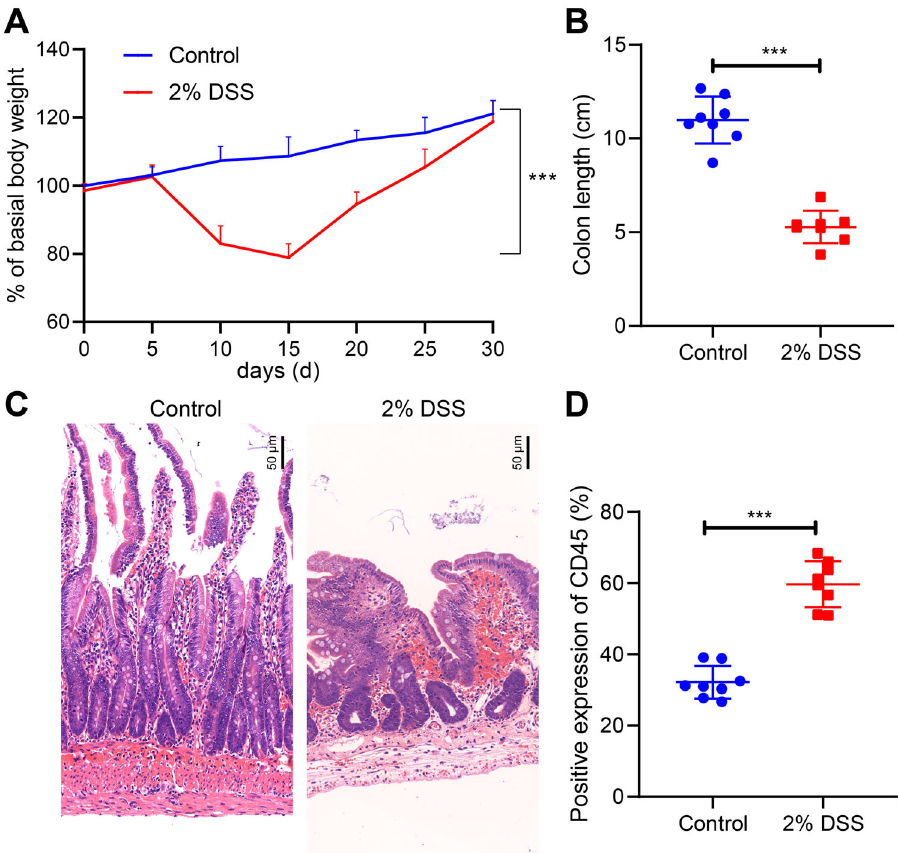
Fig. 1 Establishment and identi fi cation of experimental colitis in mice. A The statistical analysis for 30-day body weight of control mice and 2% DSS-treated mice. B Statistics for colon length of control mice and 2% DSS-induced mice. * p < 0.05 vs . the control group. C HE staining of cross-cut colon tissues in mice (200×). D Detection of CD45 positive cell rate in colon tissues of mice. The measurement data were expressed by mean ± standard deviation. Data between two groups were compared by unpaired student ’ s t test, and data at different time points were compared by repeated measures ANOVA, followed by Tukey ’ s post hoc tests. n = 8. *** p <